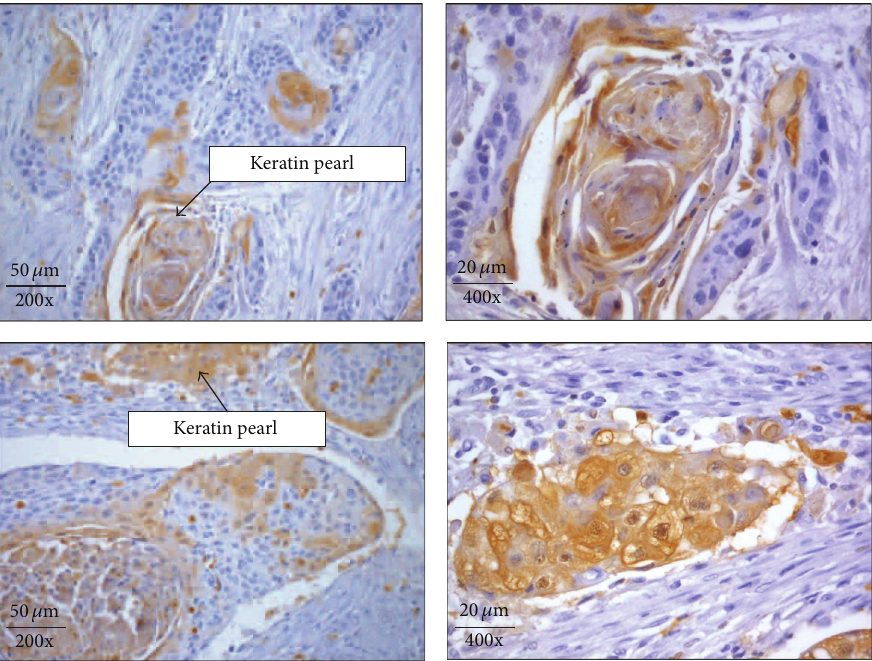
Figure 3: Expression of S100 calcium binding protein A9 in Grade I ESCC. S100A9 expression was observed in the foci of keratinization (keratin pearls) in Grade I tumors with cytoplasmic and nuclear localization. The degree of S100A9 immunostaining varied with the level of keratinization in tumor cells. Stroma showed no S100A9 expression. All the images were acquired at 200x and 400x magnification. Scale bars = 50 𝜇 m and 20 𝜇 m.